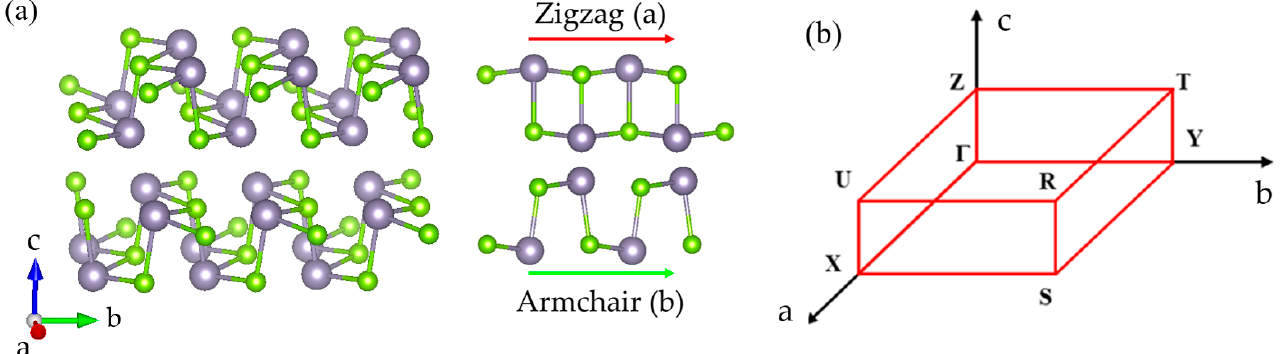
Figure 1. ( a ) Distorted-rocksalt orthorhombic (Pnma) crystal structure of SnSe. The Sn atoms are purple, while the Se atoms are green. ( b ) Brillouin zone of the SnSe structure.